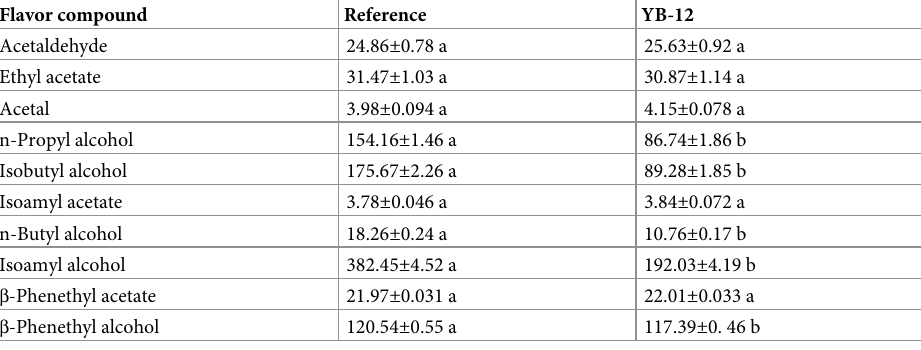
Table 4. Flavor components of rice wine fermented in a 20 L fermenter (mg/L). Flavor compound